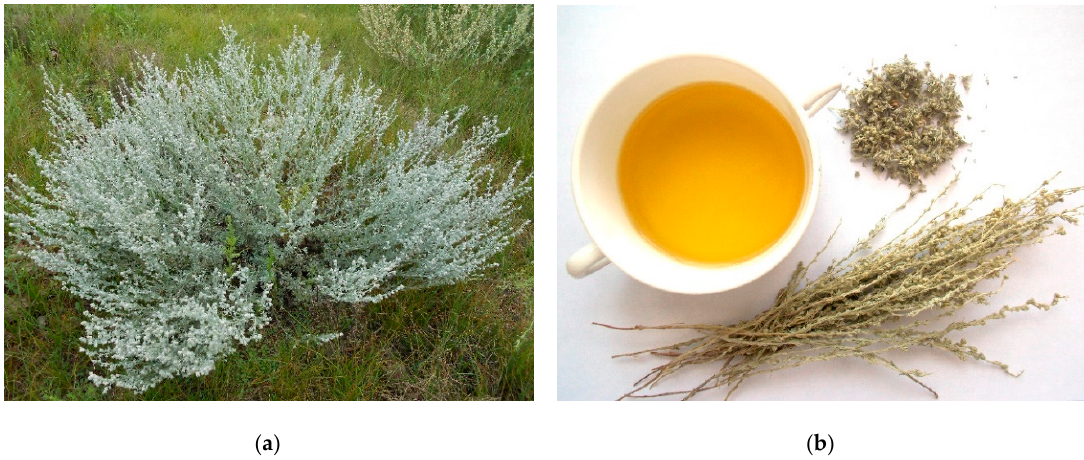
Figure 1. ( a ) Artemisia frigida plants in their natural habitat (Selenginskii Region, Buryatia Republic, Eastern Siberia); ( b ) dried herb, herbal powder and herbal tea of A. frigida .